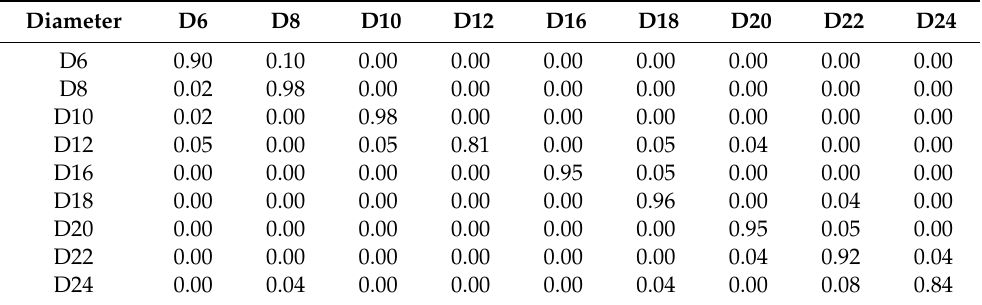
Table 7. Confusion matrix obtained by CNN network on field datasets.